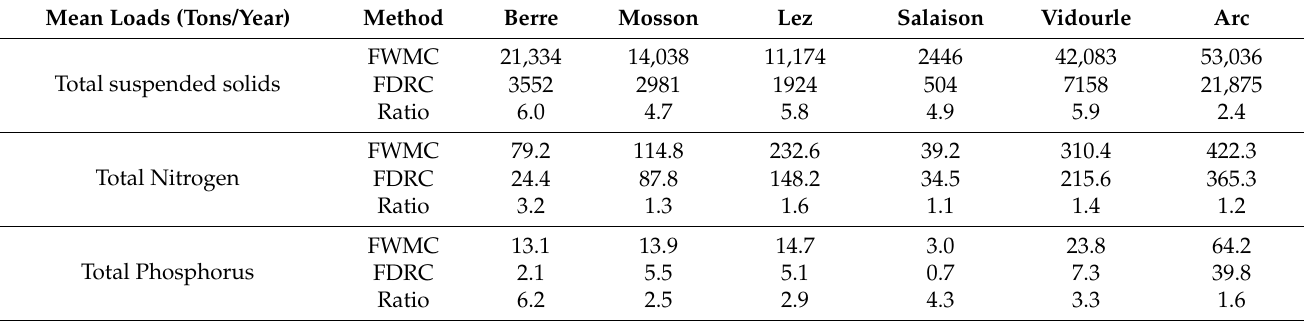
Table 6. Mean annual loads (2015–2020) of suspended solids, total nitrogen and total phosphorus calculated by the FWMC and FDRC